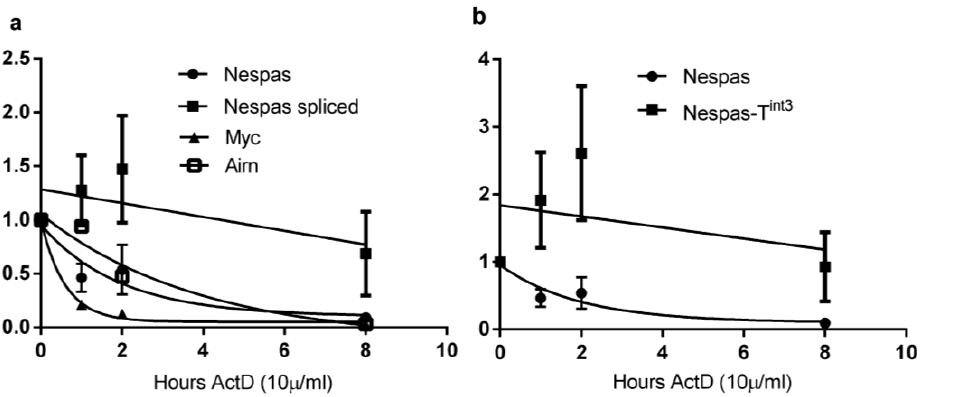
Figure 5. Stability of Nespas RNA ( a ) Wild-type Nespas RNA. Mouse embryonic fibroblasts MEFs were treated with ActinomycinD (10 μg/mL). Control untreated samples were set to 100% and Actinomycin D treated samples are shown as a % of controls. A one- phase exponential decay curve was constructed by Prism4 for unspliced Nespas RNA (black circle), spliced Nespas RNA (black square), Myc RNA (black triangle) and Airn RNA (open square); ( b ) Stability of Nespas-T int3 RNA. Wild-type Nespas RNA (black circle) and Nespas-T int3 RNA (black